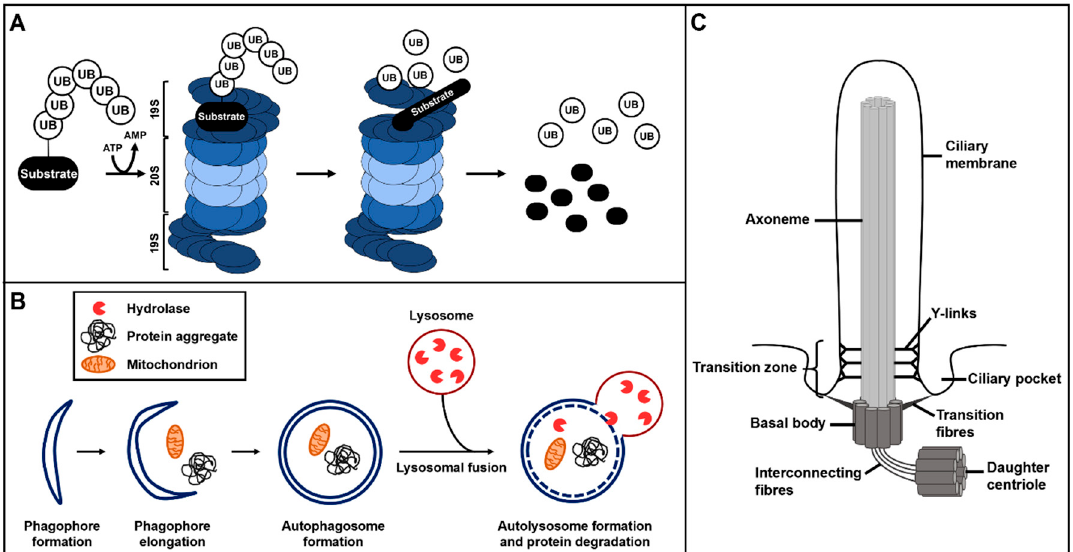
Figure 1. Overview of ubiquitin–proteasome system (UPS) protein degradation, autophagy and primary cilium structure. ( A ) The ubiquitin–proteasome system. The ubiquitinated substrate is recognised